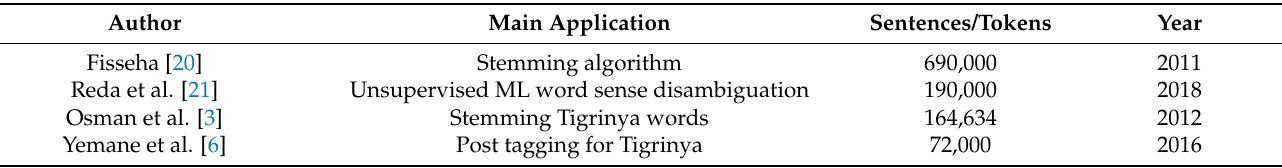
Table 1. Literature review of previous Tigrinya natural language processing (NLP) research papers.